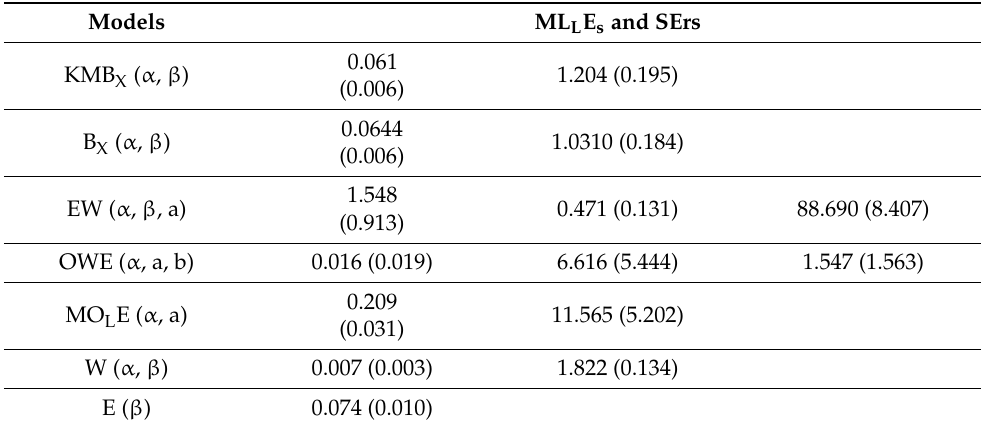
Table 11. Numerical values of ML L E s and (SErs) for the third data set.